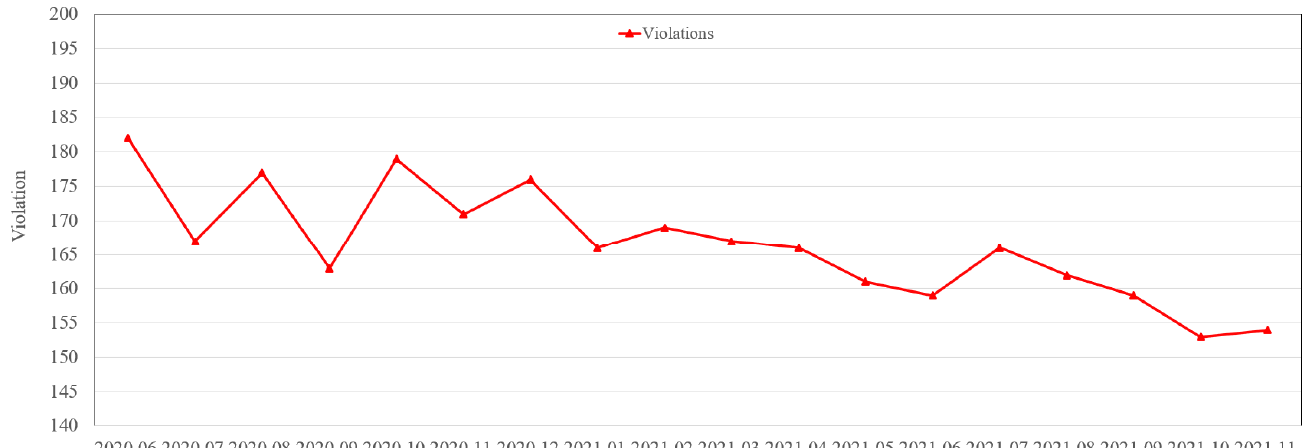
Figure 11. Development trend of violation from 2020 to 2021.